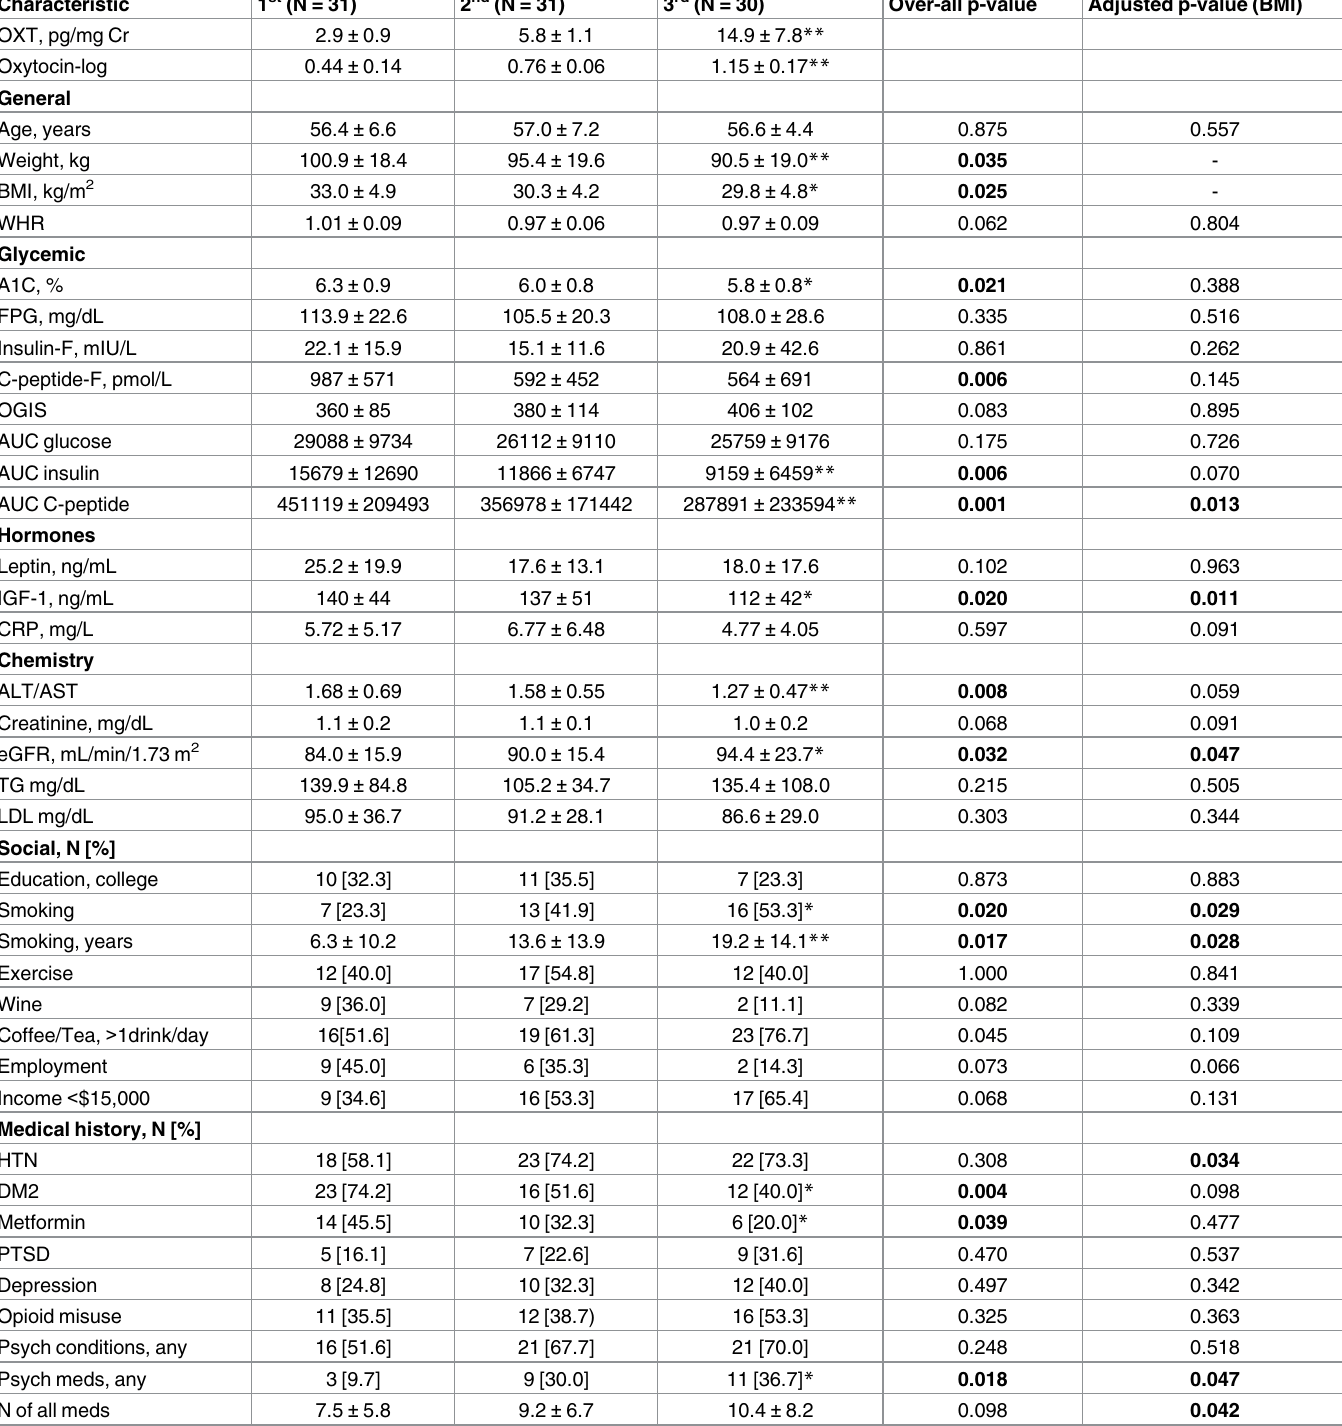
Table 1. Characteristics of male veteransby the tertiles of oxytocin